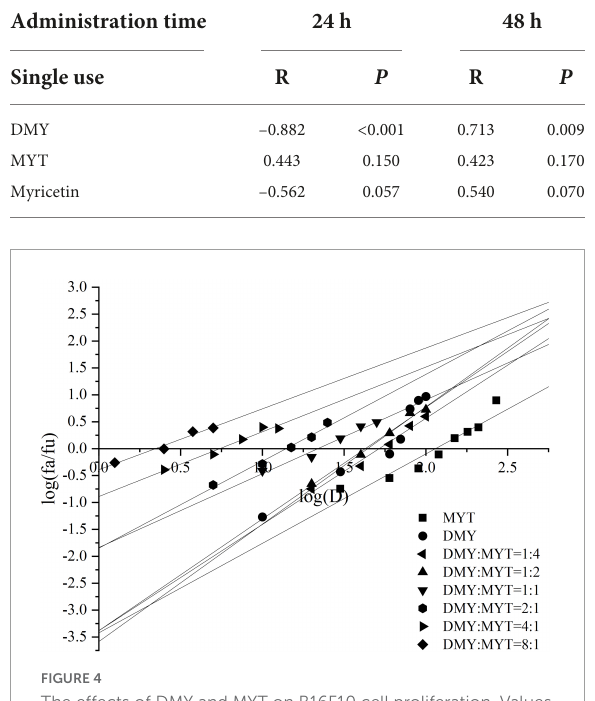
FIGURE4 The effects of DMY and MYT on B16F10 cell proliferation. Values are means ± SD ( n = 3). B16F10 cells were treated with DMY, MYT, or mix-use (1:4 ∼ 8:1) for 72 h, before assessment of viability by MTT assay. The dose-response relationship was obtained by transformation according to the equation. DMY, dihydromyricetin; MYT, myricitrin.